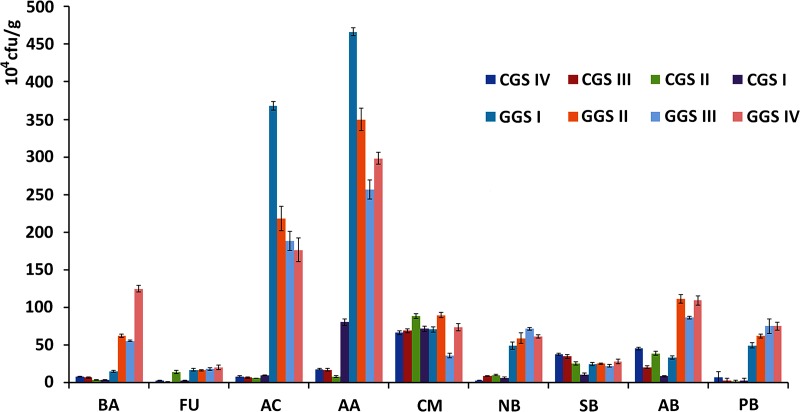
Amounts of rhizosphere soil microorganisms.Bacteria (BA), Fungi (FU), Actinomycetes (AC), Abiogenous Azotobacter (AA), Cellulose-decomposing Microorganisms (CM), Nitrifying Bacteria (NB), Sulfur Bacteria (SB), Ammonifying Bacteria (AB), and Potassium Bacteria (PB) were counted. Eight samples from each of three replicate plots were averaged. Values are mean±standard deviation.